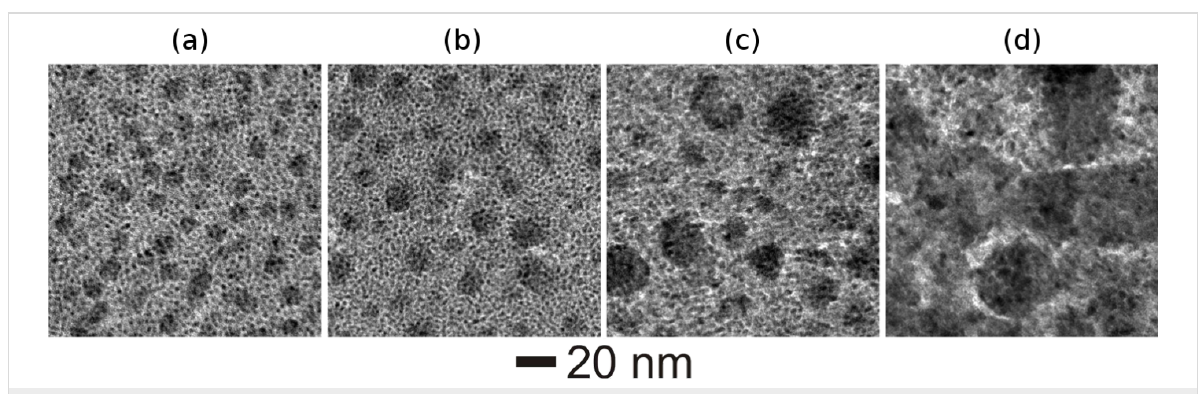
Figure 2: Bright field TEM morphologies of Ag–TiO 2 nanocomposite films with different metal volume filling fractions, (a) 15%, (b) 26%, (c) 34% and (d) 47%.